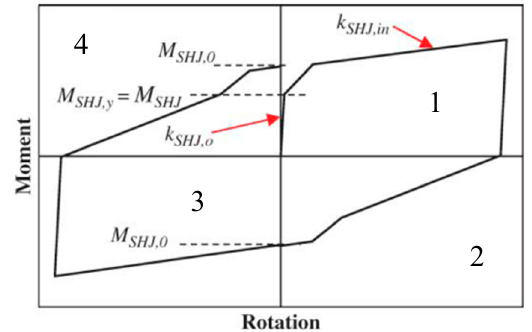
Figure 7. SHJ with conventional AFC behaviour spine curve [18].